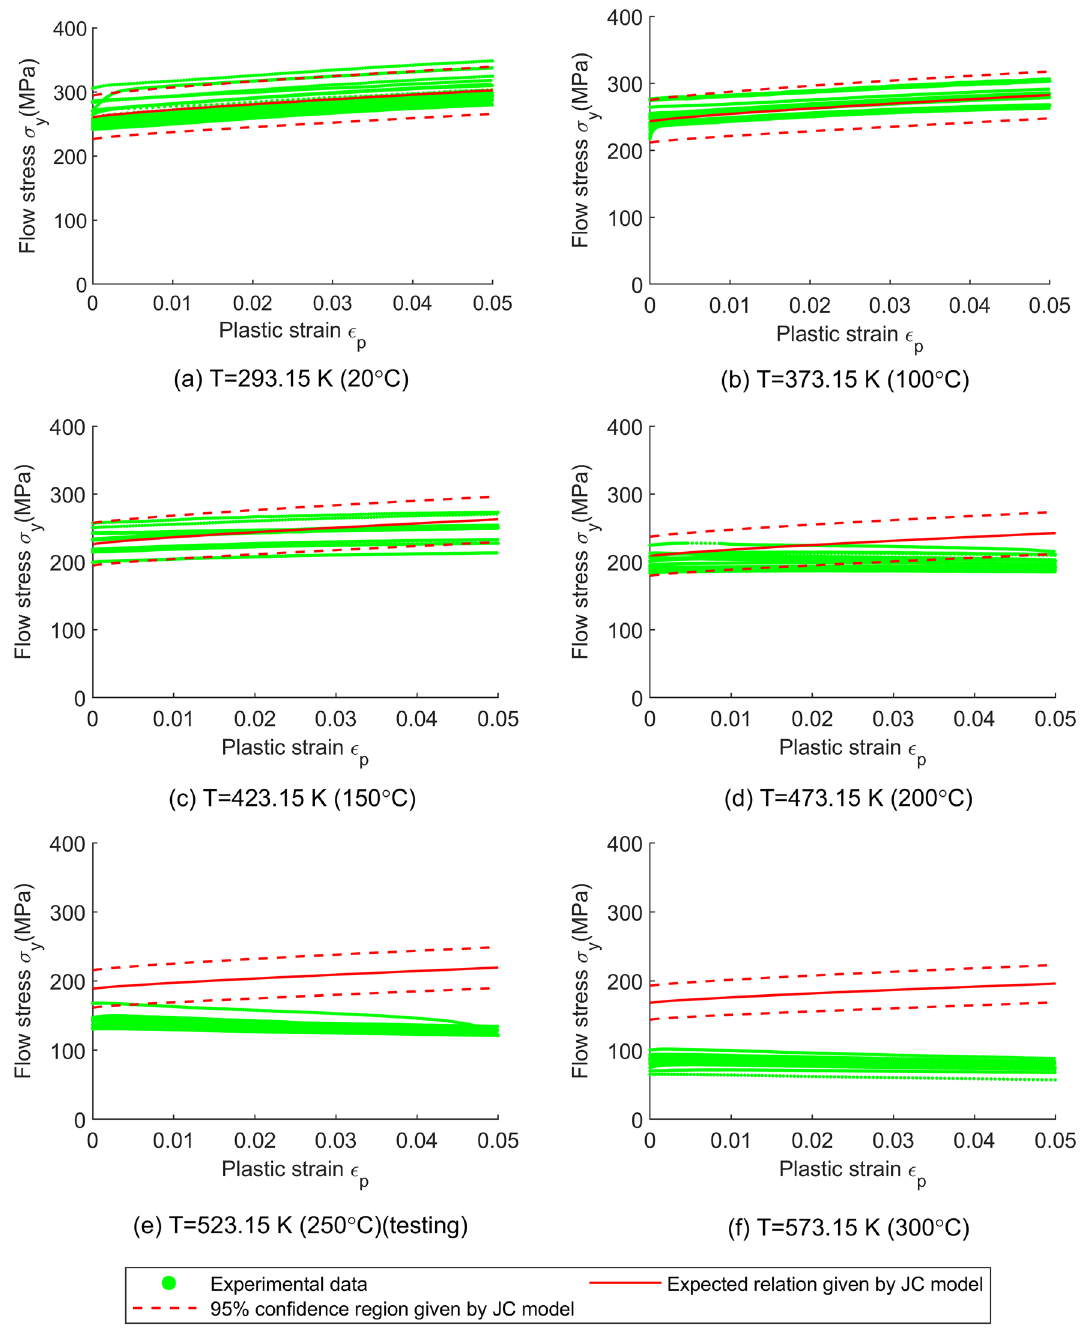
Figure 7. The flow stress obtained using the JC model with respect to the plastic strain at the temperature of ( a ) 20 °C, ( b ) 100 °C, ( c ) 150 °C, ( d ) 200 °C, ( e ) 250 °C and ( f ) 300